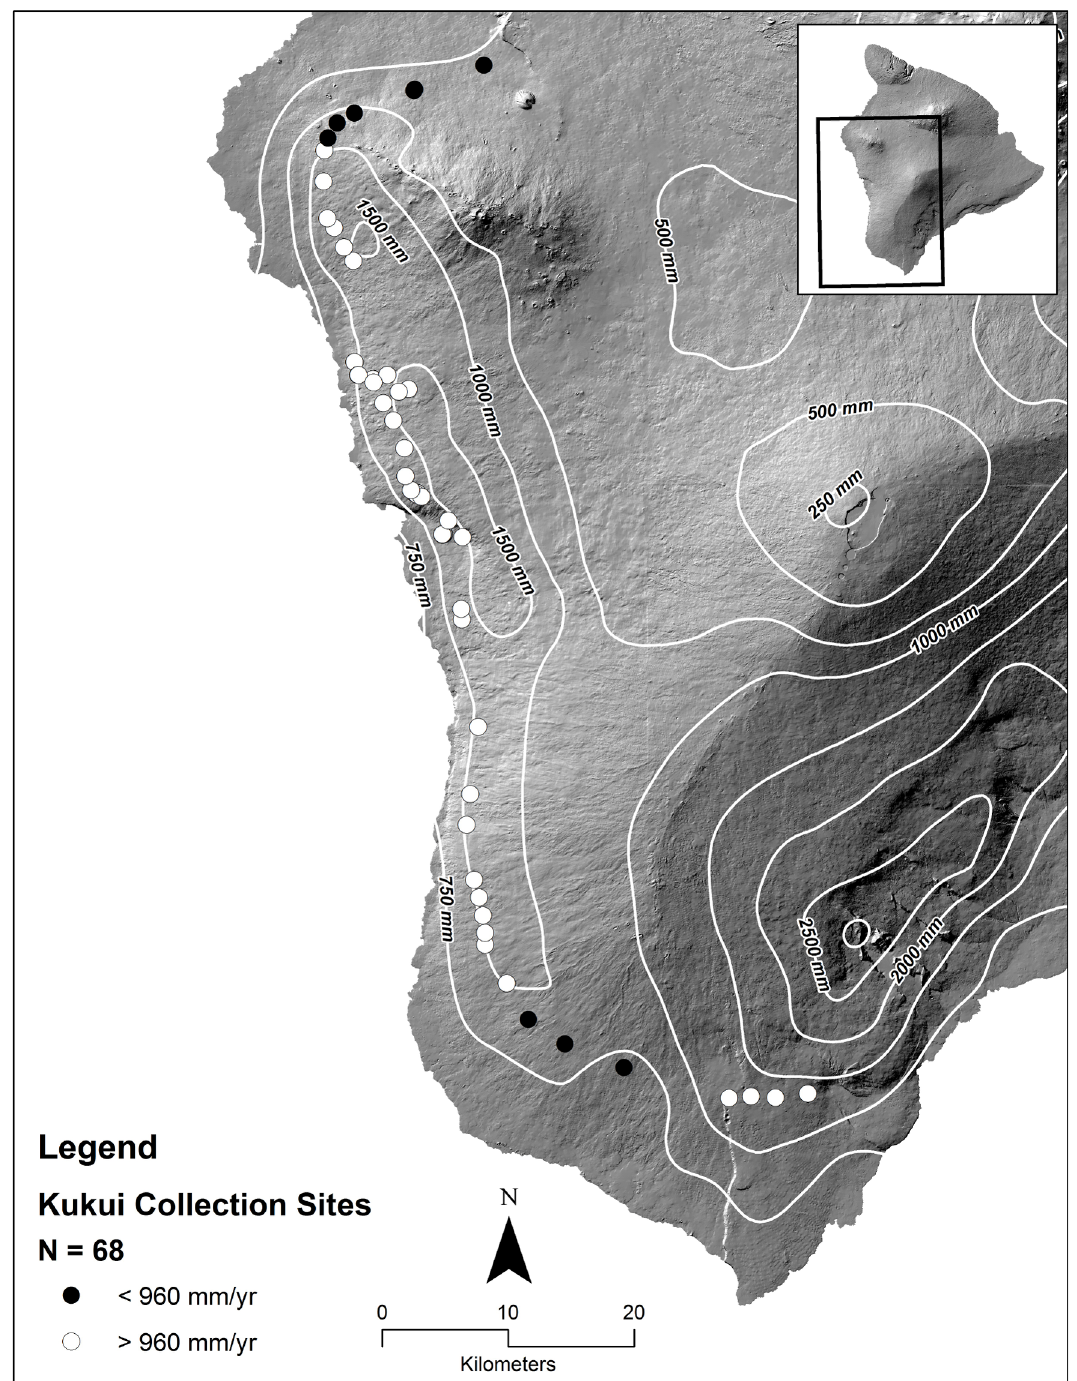
Fig 1. Map of sampling locations. Each point represents collection site representing multiple trees; black dots indicate areas that receive less an annual rainfall of less than 970